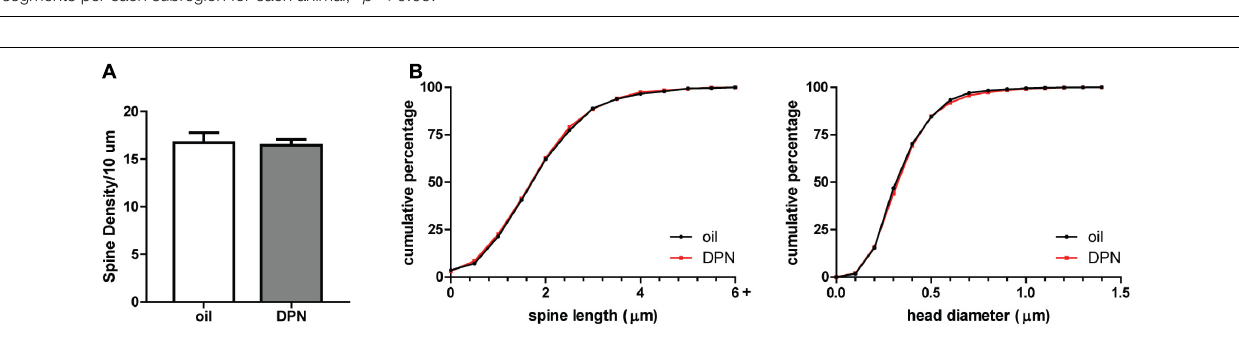
FIGURE 3 | ER β activation does not influence spine plasticity in the NAcSh of castrated male rats. (A) Average spine density per 10 µ m of MSNs in the NAcSh 24 h after systemic administration of DPN (1 mg/kg). (B) Spine morphology of MSNs in the NAcSh as assessed by binned cumulative probability distributions of spine length and head diameter in vehicle and DPN treated groups. n = 4 animals per group with spine density averaged from 6 to 9 dendritic segments per